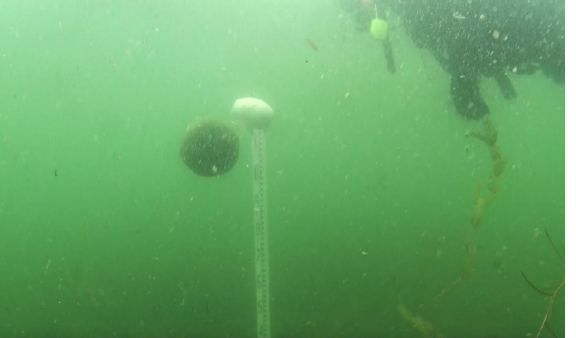
Figure 8. Field observation for estimating the underwater specific density of Marimo at Churui Bay in Lake Akan.